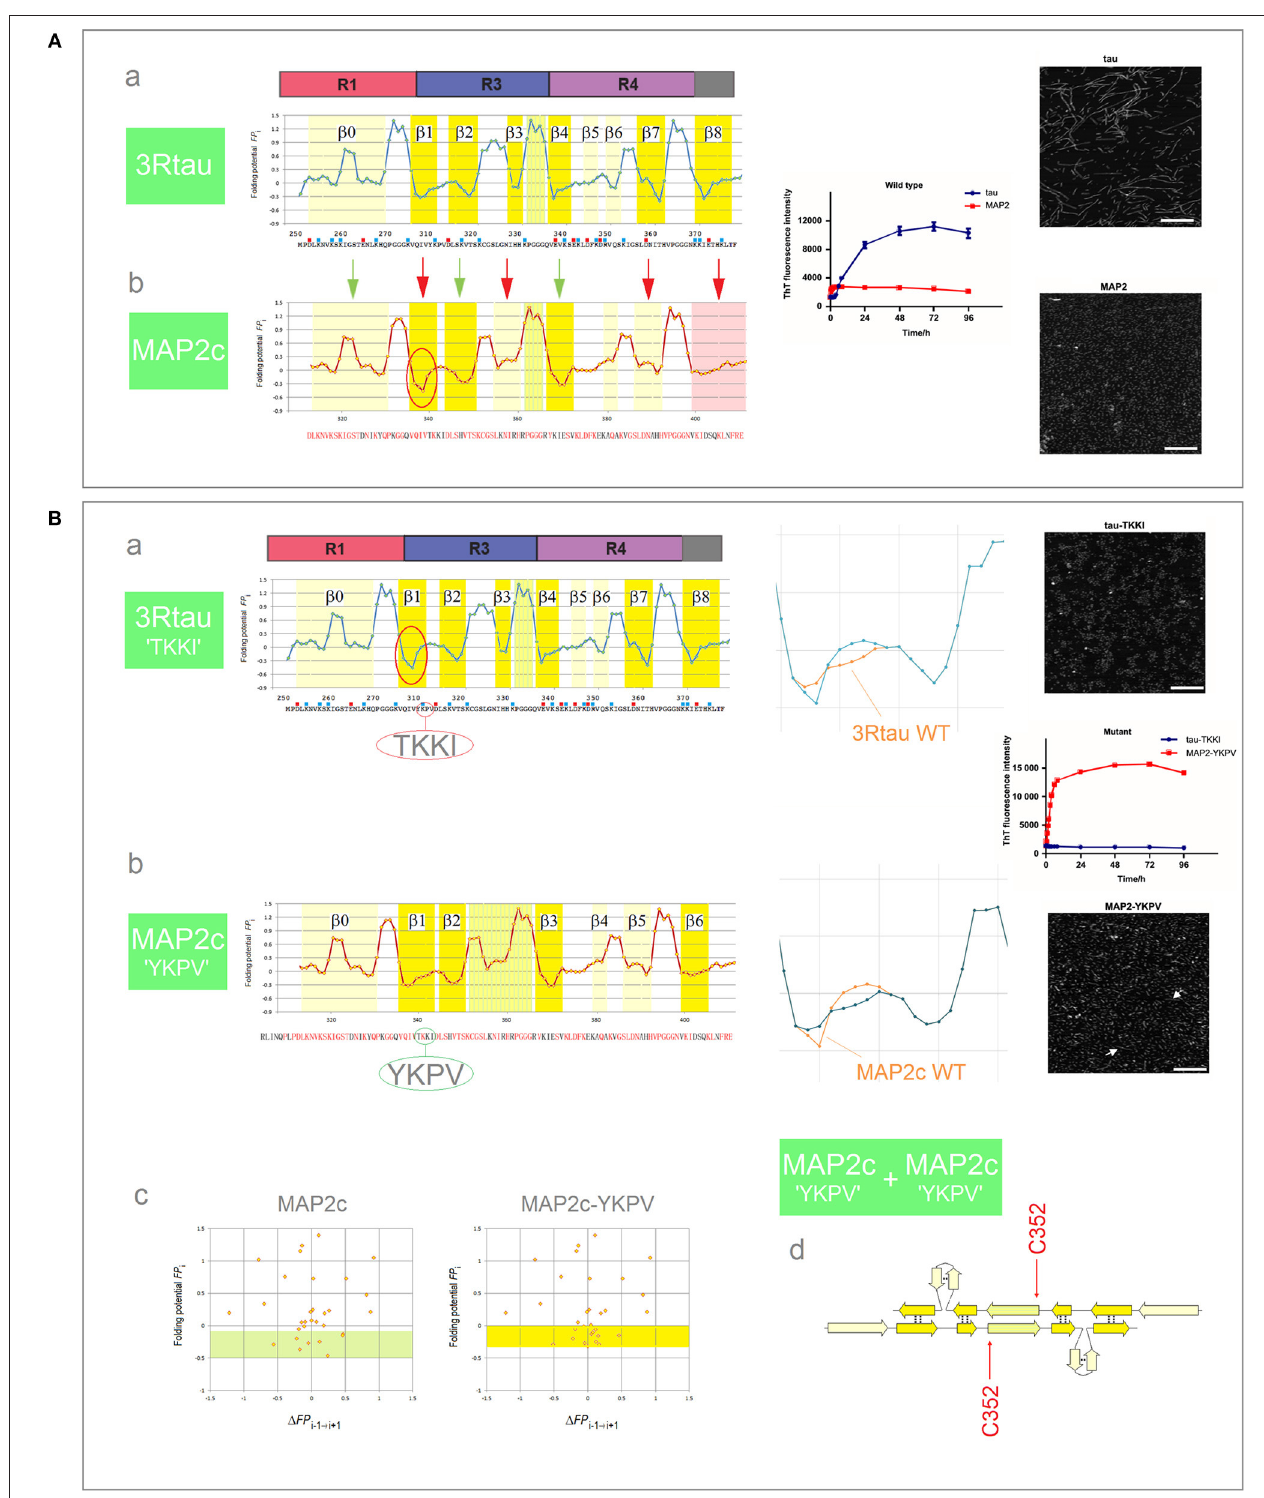
FIGURE 9 | Electronic configuration of the polypeptide backbone and the aggregation properties of MAP homologs. (A) (a) The FP i profile of the 3R (R1-R3R4) isoform of tau and the anticipated secondary structure propensity in water. The adjacent plot of the ThT fluorescence intensity vs. time (blue curve) and the insert show the assembly of PHFs; (b) The FP i profile of MAP2c and the anticipated secondary structure propensity in water. The adjacent plot (red curve) and the insert show that